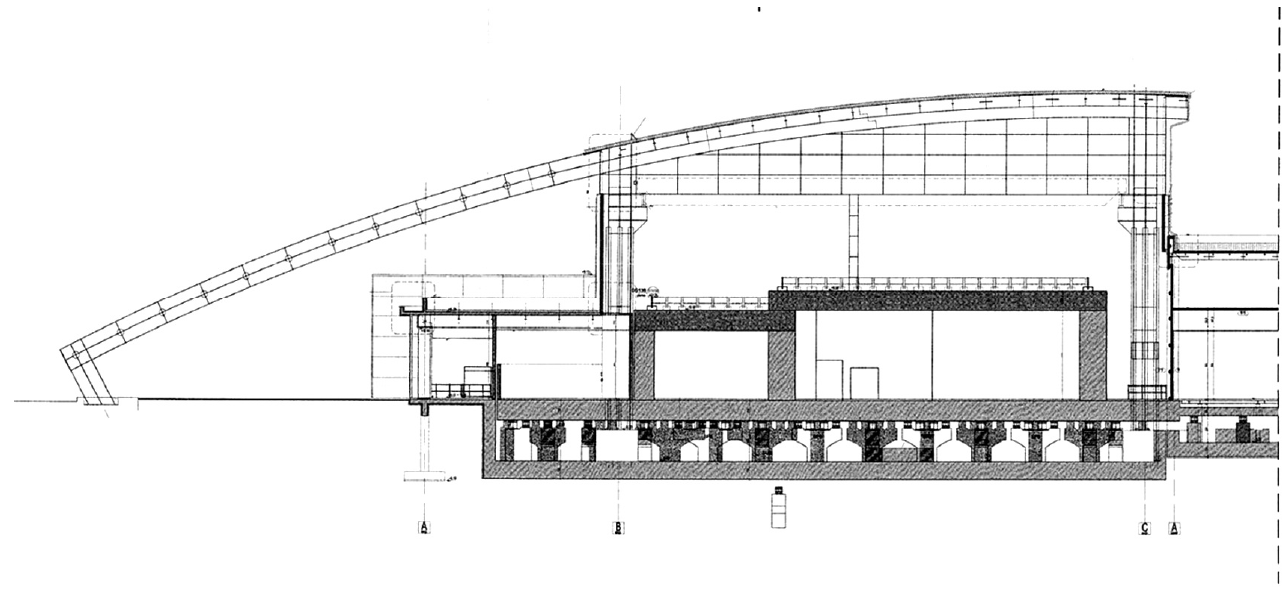
Figure 1. Lateral view of the facility.